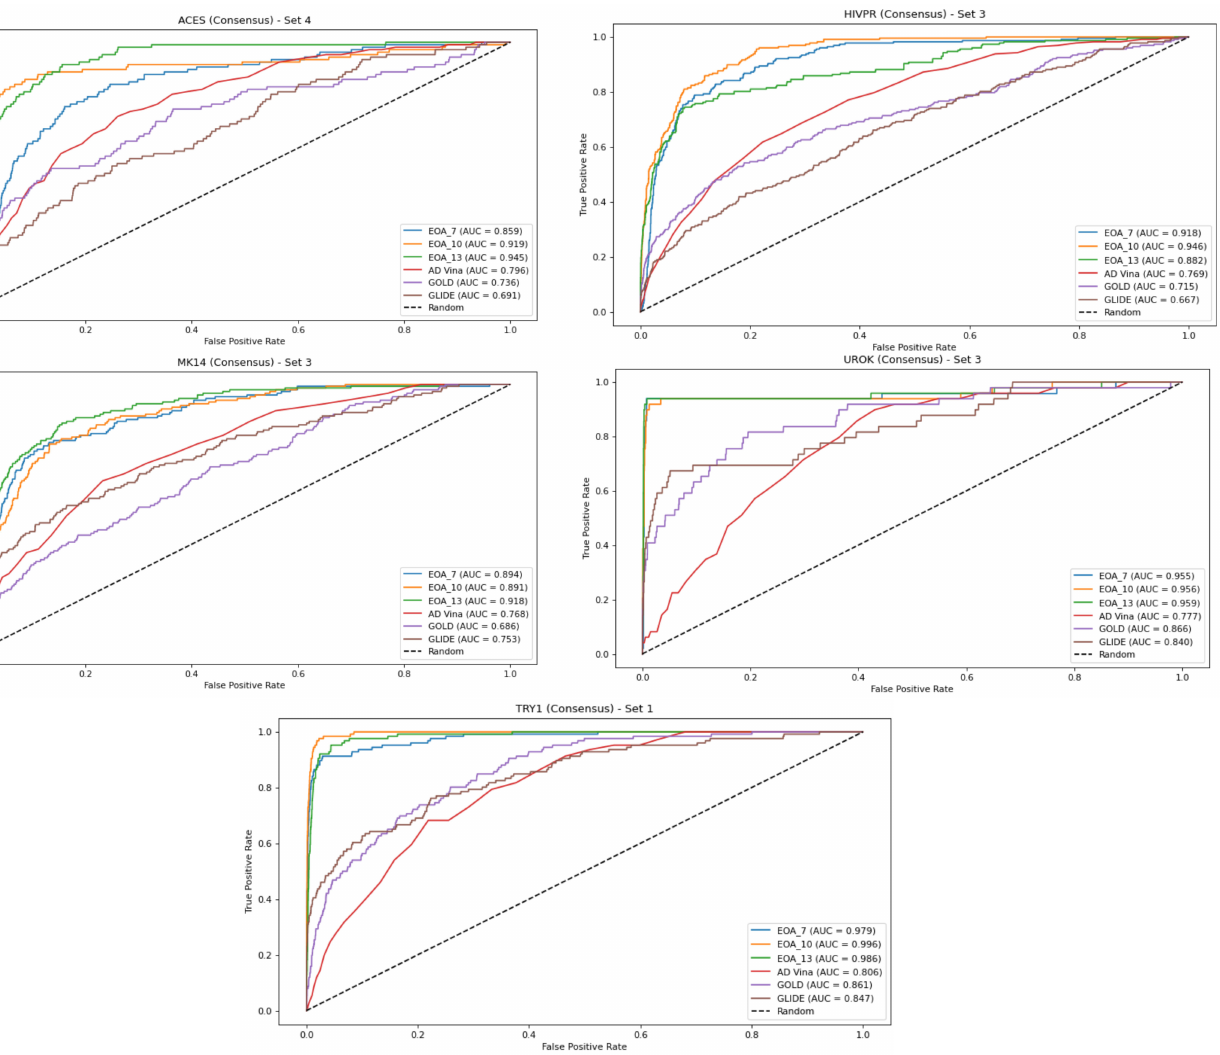
Figure 1. ROC curves for the best-performing docking method based on the consensus approach compared with EOA and the other docking methods (see text for more details). In all cases, the EOA performed better than all docking